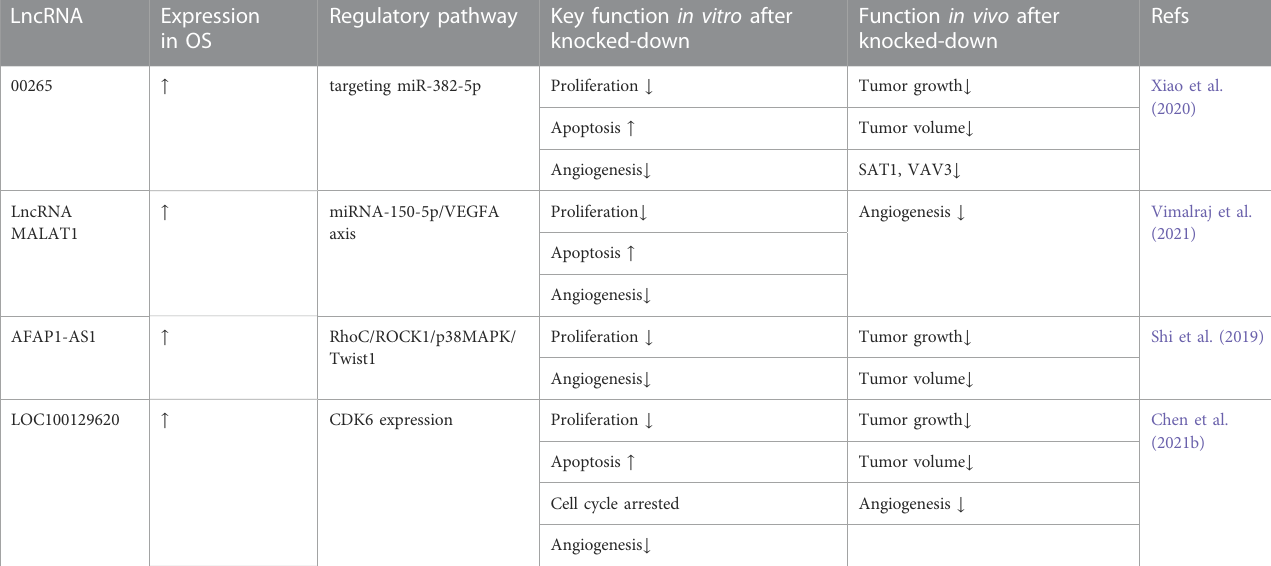
TABLE 3 Oncogenic lncRNAs associated with reduced osteosarcoma angiogenesis.